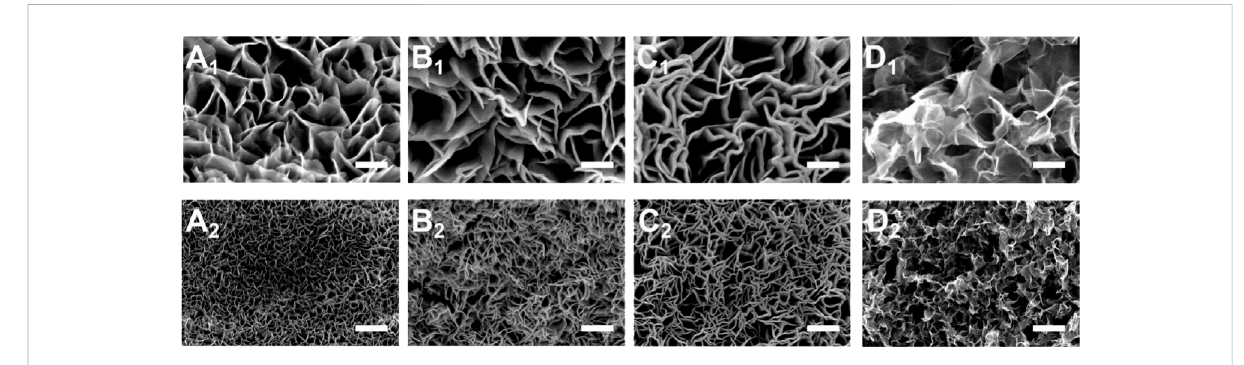
FIGURE 2 SEM images of Mo-Co 3 O 4 for different cooling temperatures in the quenching strategy (scale bar: 1: 100 nm; 2: 1 μ m; (A) 40 ° C; (B) 20 ° C; (C) 0 ° C; (D) 20 ° C).